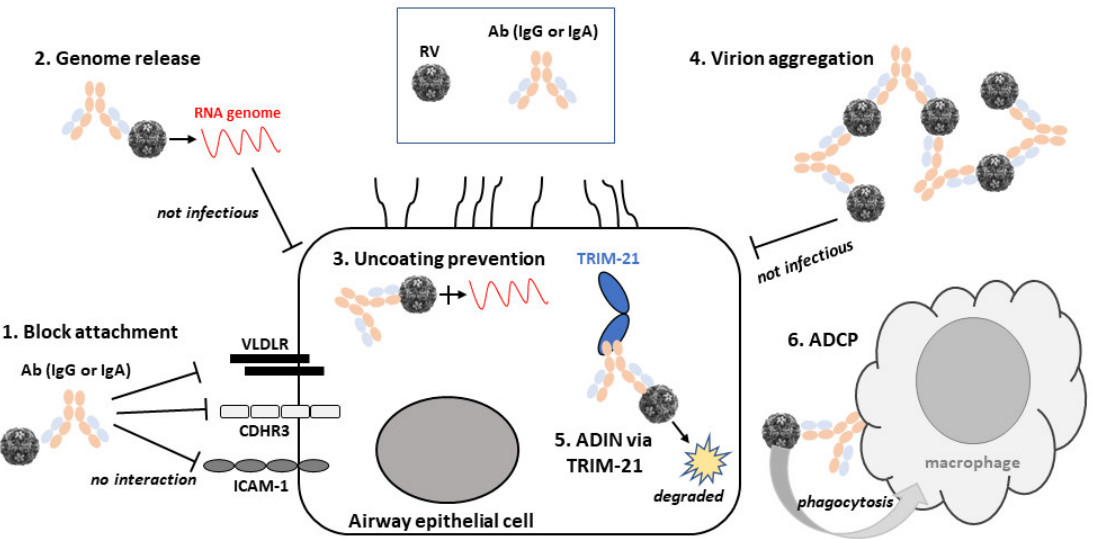
Figure 2. Mechanisms of rhinovirus (RV) neutralisation by Abs. A schematic diagram of an airway epithelial cell and the variety of neutralisation mechanisms of RV by Abs. Molecules are not drawn to scale. Abbreviations are as follows: RV, rhinovirus; Ab, antibody; VLDLR, very low-density lipoprotein receptor; CDHR3, cadherin-related protein 3; ICAM-1, intercellular adhesion molecule 1; ADIN, antibody-dependent intracellular neutralisation; TRIM-21, tripartite motif containing-21; ADCP, antibody-dependent cellular phagocytosis.